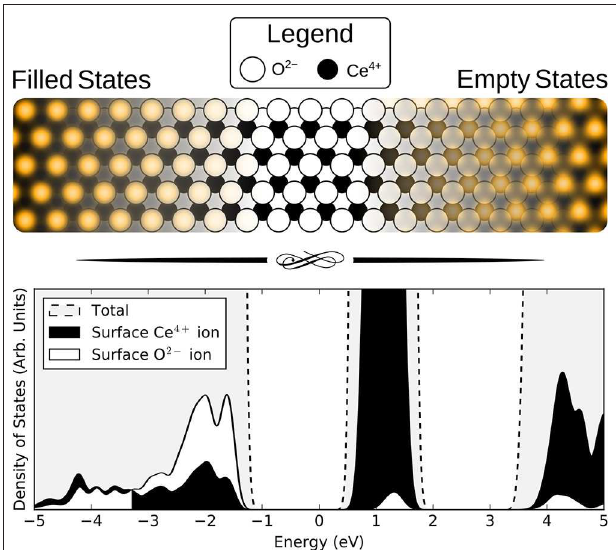
FIGURE 1 | (Upper) Simulated STM images of the stoichiometric CeO 2 (111) surface using bias voltages of − 3.0 V (filled states) and + 3.0 V (empty states). The location of the ions is indicated by superimposing the STM images over a schematic top-view of the surface with white and black circles corresponding to oxygen and cerium ions, respectively. (Lower) Density of states (DOS) plots for the stoichiometric slab. Total DOS shown (gray) with dashed lines and projections onto a surface oxygen ion and a surface cerium ion are shown by white and black filled curves,